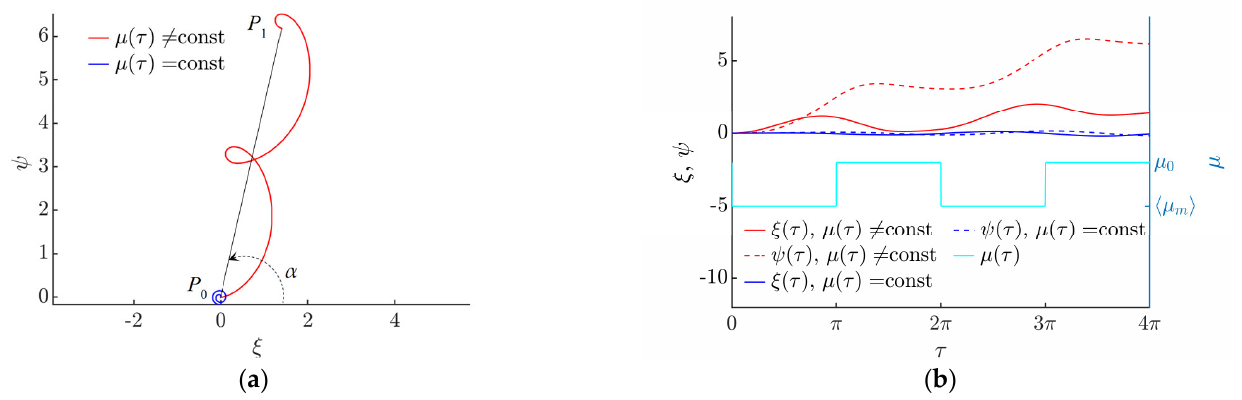
Figure 4. Nondimensional displacement of the particle when γ = 4.9, μ 0 = 0.2, ⟨ μ m ⟩ / μ 0 = 0.25, λ = π , ϕ = 0: ( a ) motion trajectories of the particle and the angle of displacement α . ( b ) horizontal ξ and vertical ψ components of the nondimensional displacement vs. the nondimensional time and the variation of the effective dry friction coefficient.